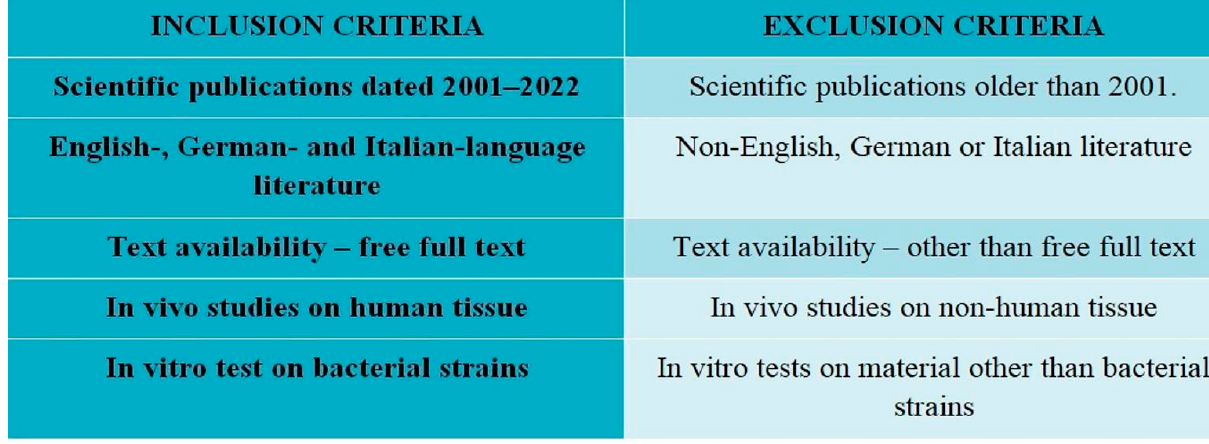
Figure 2. Inclusion and exclusion criteria used in this literature review.